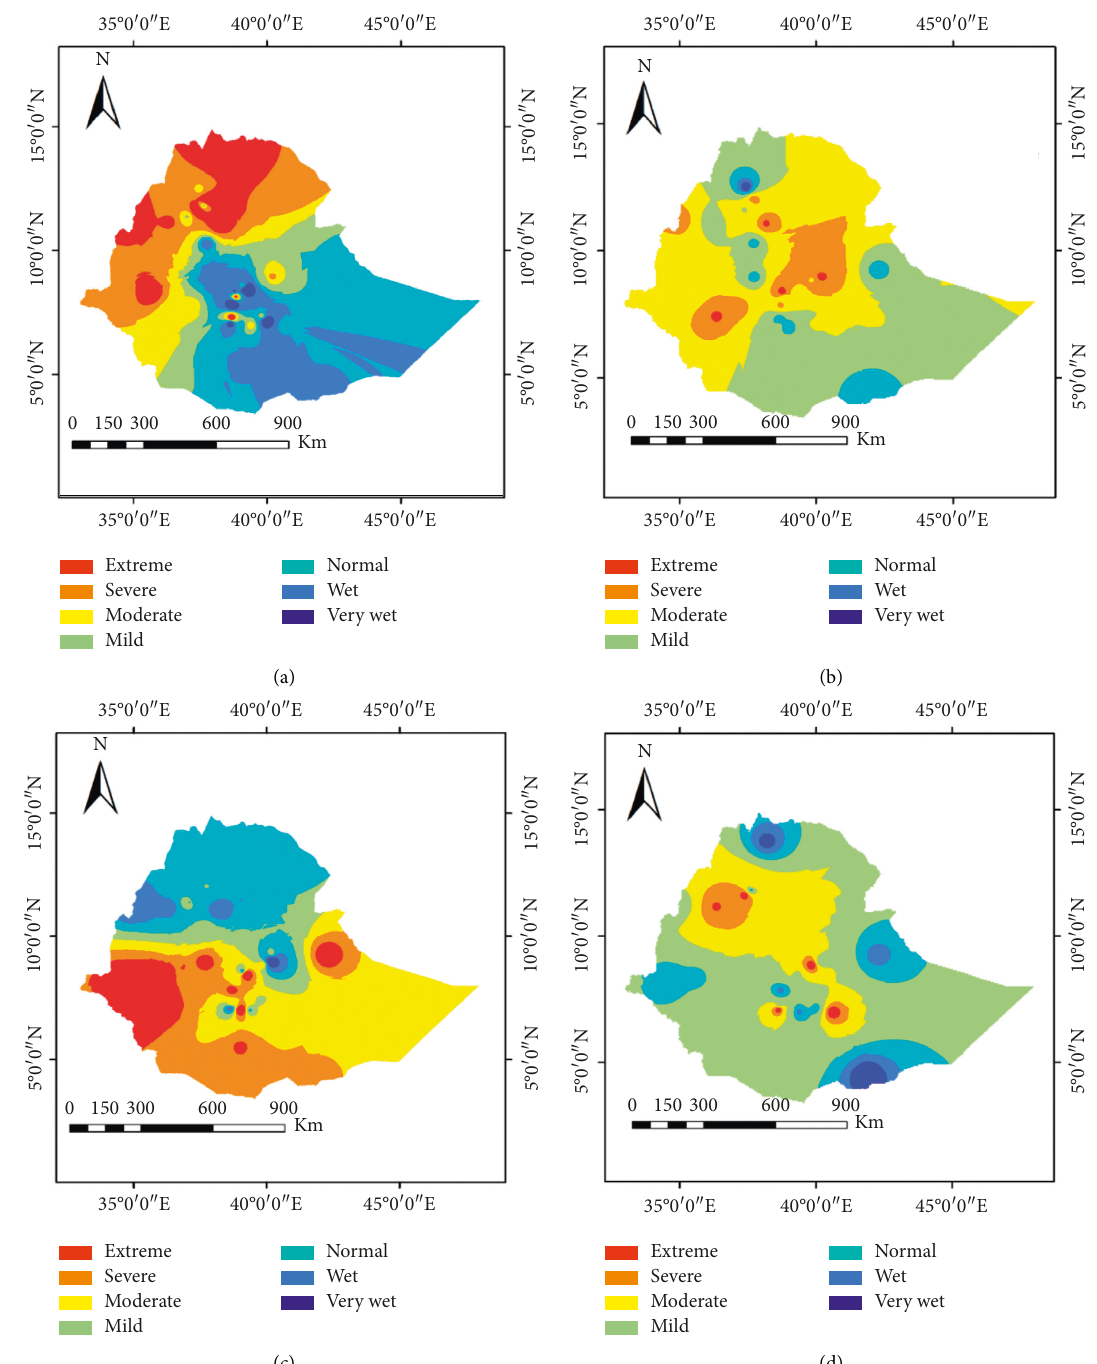
Figure 12: Spatial variation of streamflow drought in Ethiopia in four severe drought years. (a). SDI 1984. (b). SDI 1986. (c). SDI 2002. (d). SDI